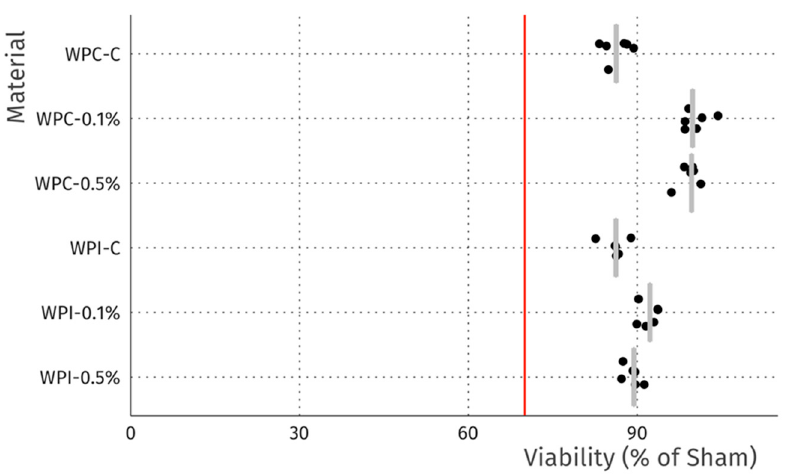
Figure 5. Viability of L929 fibroblasts after 24 h incubation with extracts. Data is normalized to sham extract. Dots represent technical replicates, grey bars represent median, and the red line indicates 70% viability, the threshold for cytotoxicity.